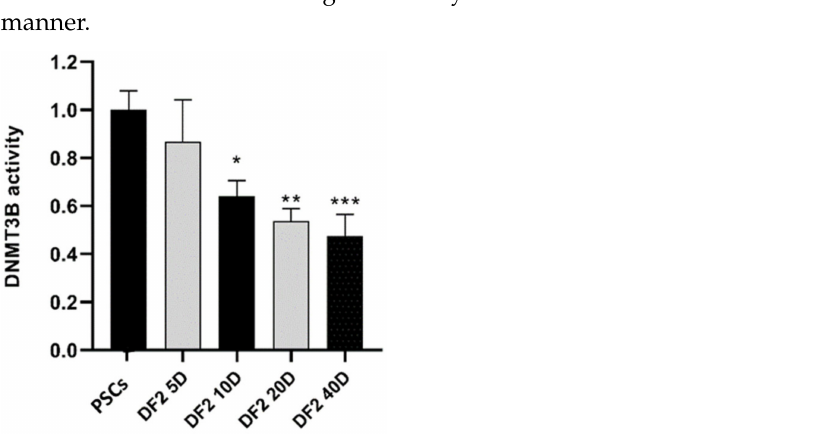
Figure 6. DNMT3B enzyme activity in PSCs in 2% WKS. Protein samples were isolated from undif- ferentiated and 5, 10, 20, 40 days differentiated cells exposed to physoxia conditions. The absorbance values of differentiated cells were normalised to undifferentiated sample. Data are presented as a mean ( n = 3), * p < 0.05, ** p < 0.01, *** p <